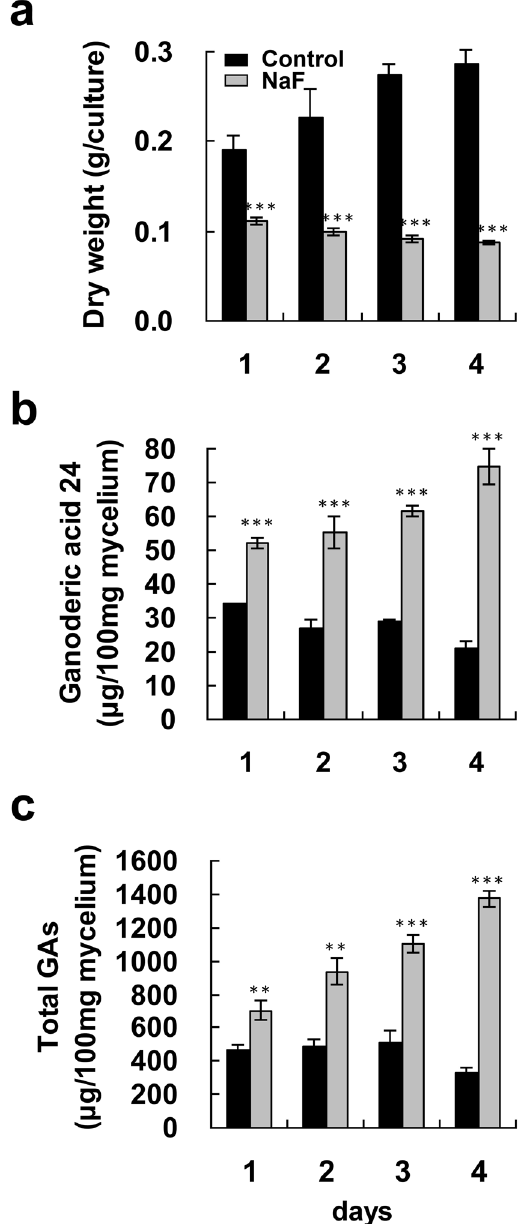
Figure 5. Time-course of fungal biomass and ganoderic acid production by Ganoderma lucidum treated with NaF. Four-day-old fungal mycelium was cultured on potato dextrose agar (PDA) in 9-cm diameter petri dishes and then incubated with 20 mM NaF in 25 ml potato dextrose broth (PDB) for 1–4 days. Dried mycelium was used to measure fungal biomass ( a ). Both lanosta-7,9(11), 24-trien-3 α -o1-26-oic acid (ganoderic acid 24) ( b ), and total ganoderic acids (GAs) ( c ) were measured by HPLC. The means of three independent samples with standard deviations are presented. * p < 0.05, ** p < 0.01, *** p < 0.001 as compared with the control